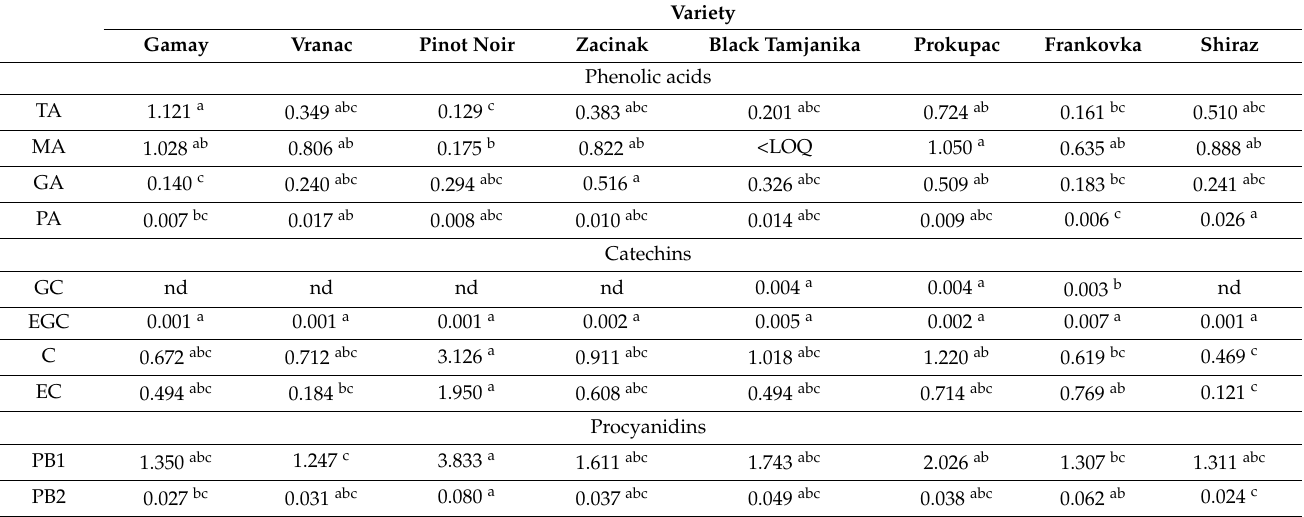
Table 3. Phenolic compounds quantified in ChCit GSEs (results are expressed as mg/g of dry weight).